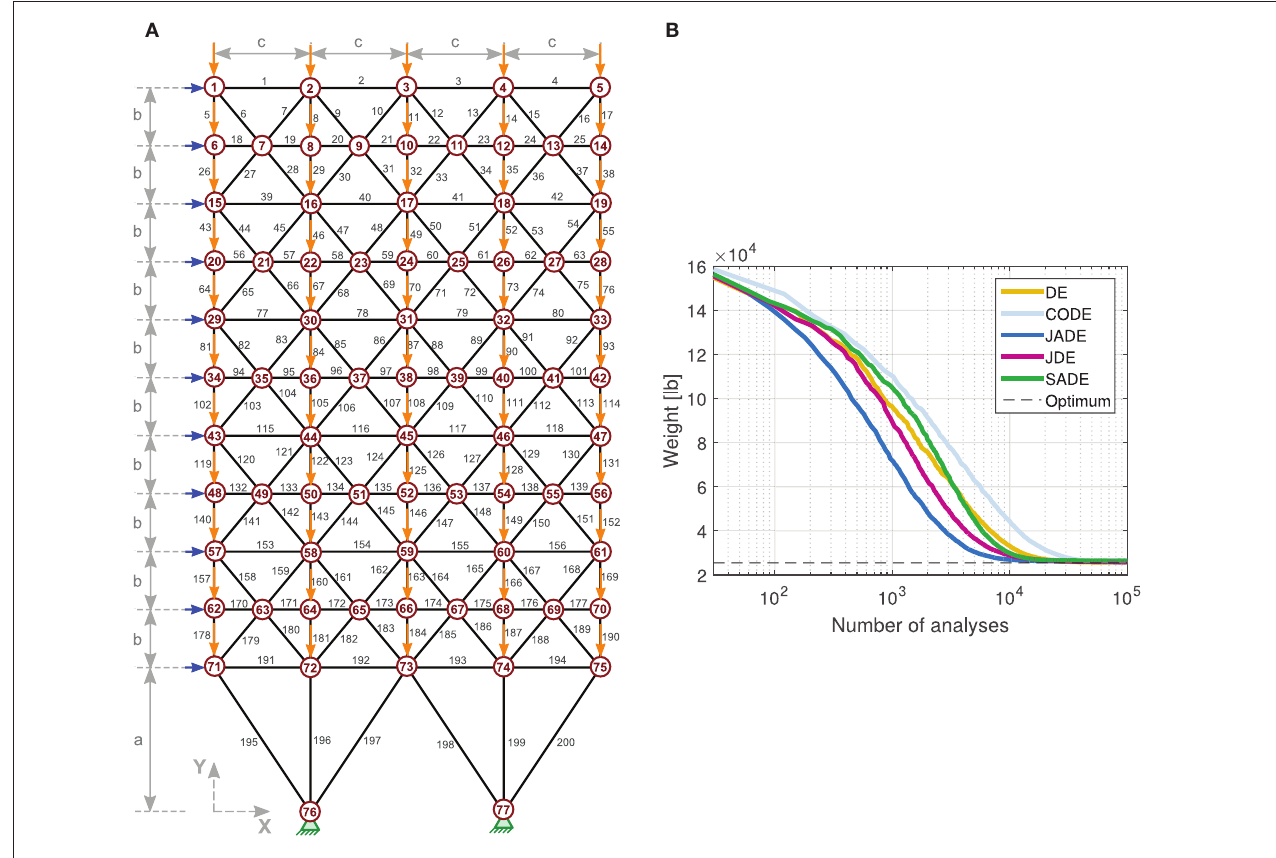
FIGURE 5 | 200-bar plane truss (A) geometry. Load Cases 1 and 2 are depicted with blue and orange arrows, respectively; (B) algorithms’ convergence histories (average of 30 runs).